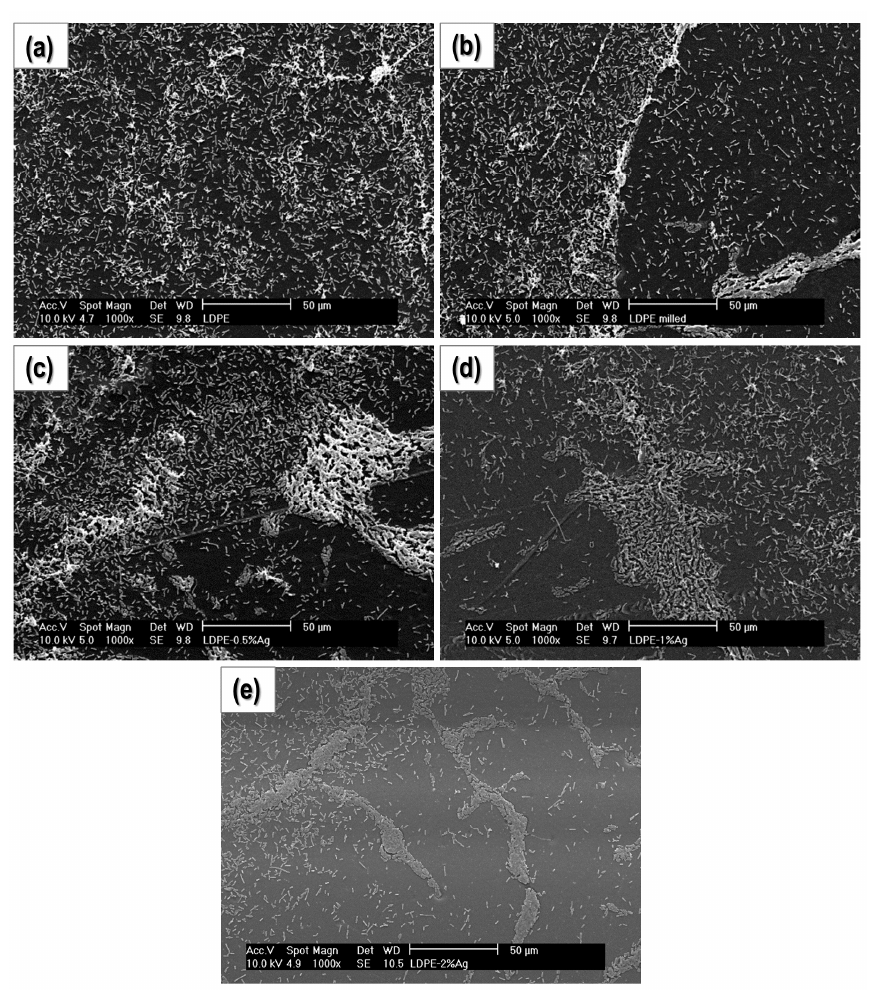
Figure 5. SEM micrographs obtained at 1000× for: ( a ) PE-Ground; ( b ) PE-Milled; ( c ) PE-0.5% Ag; ( d ) PE-1% Ag and ( e ) PE-2% Ag.